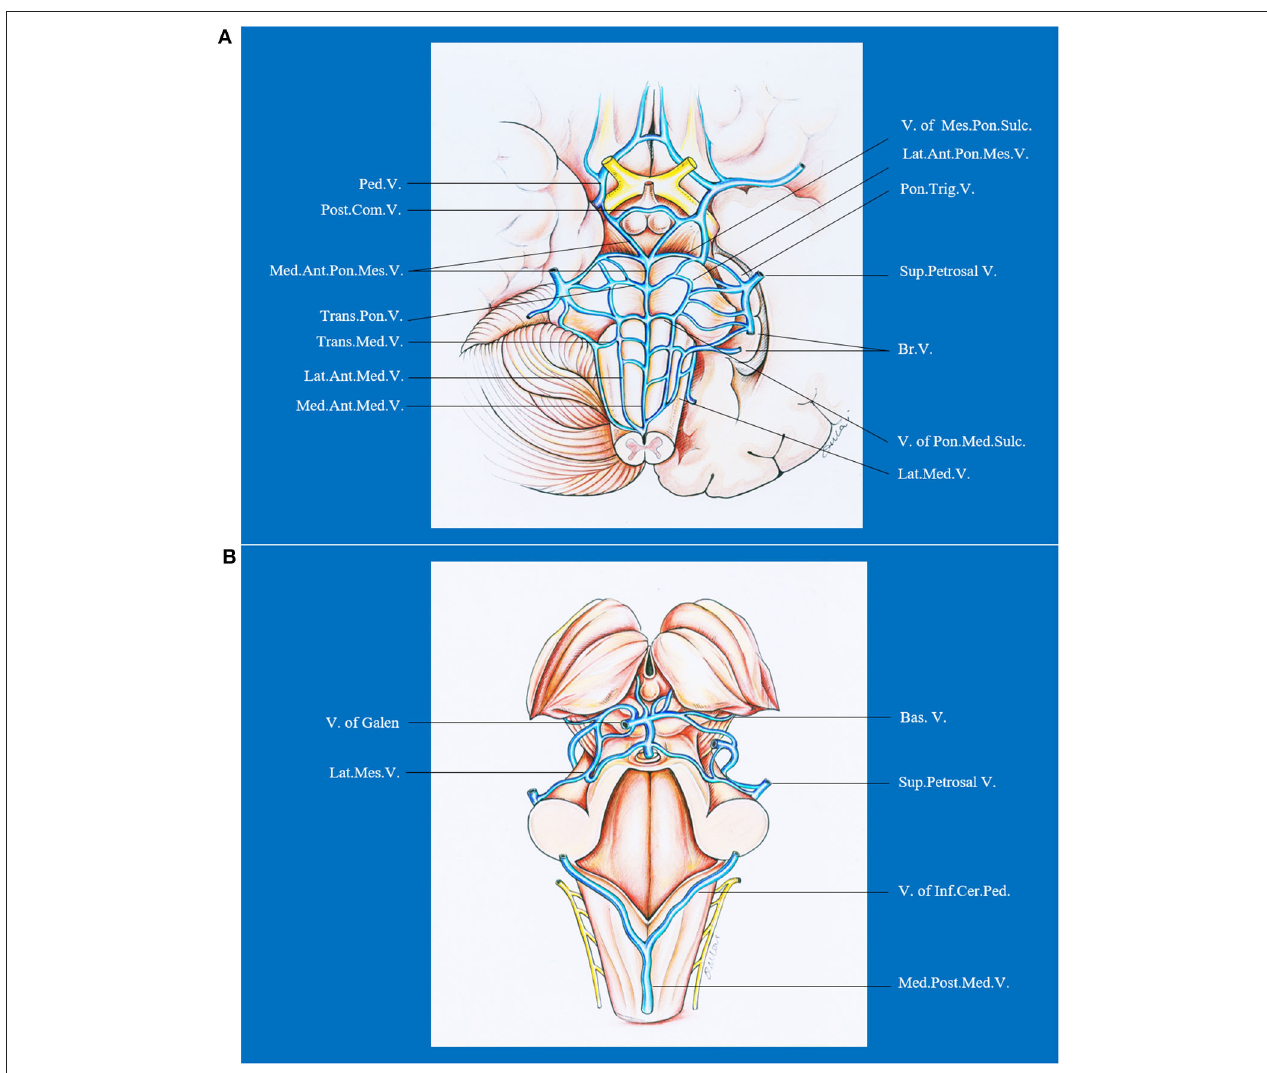
FIGURE 5 | Ventral (A) and dorsal (B) venous drainage of the brainstem. Ant., anterior; Bas., basilar; Br., bridging; Cer., cerebellar; Com., communicating; Inf., inferior; Lat., lateral; Med., median, medullary; Mes., mesencephalic; Ped., peduncle; Pon., pontine; Post., posterior; Sul., sulcus; Sup., superior; Trans., transverse; Trig., trigeminal; V.,